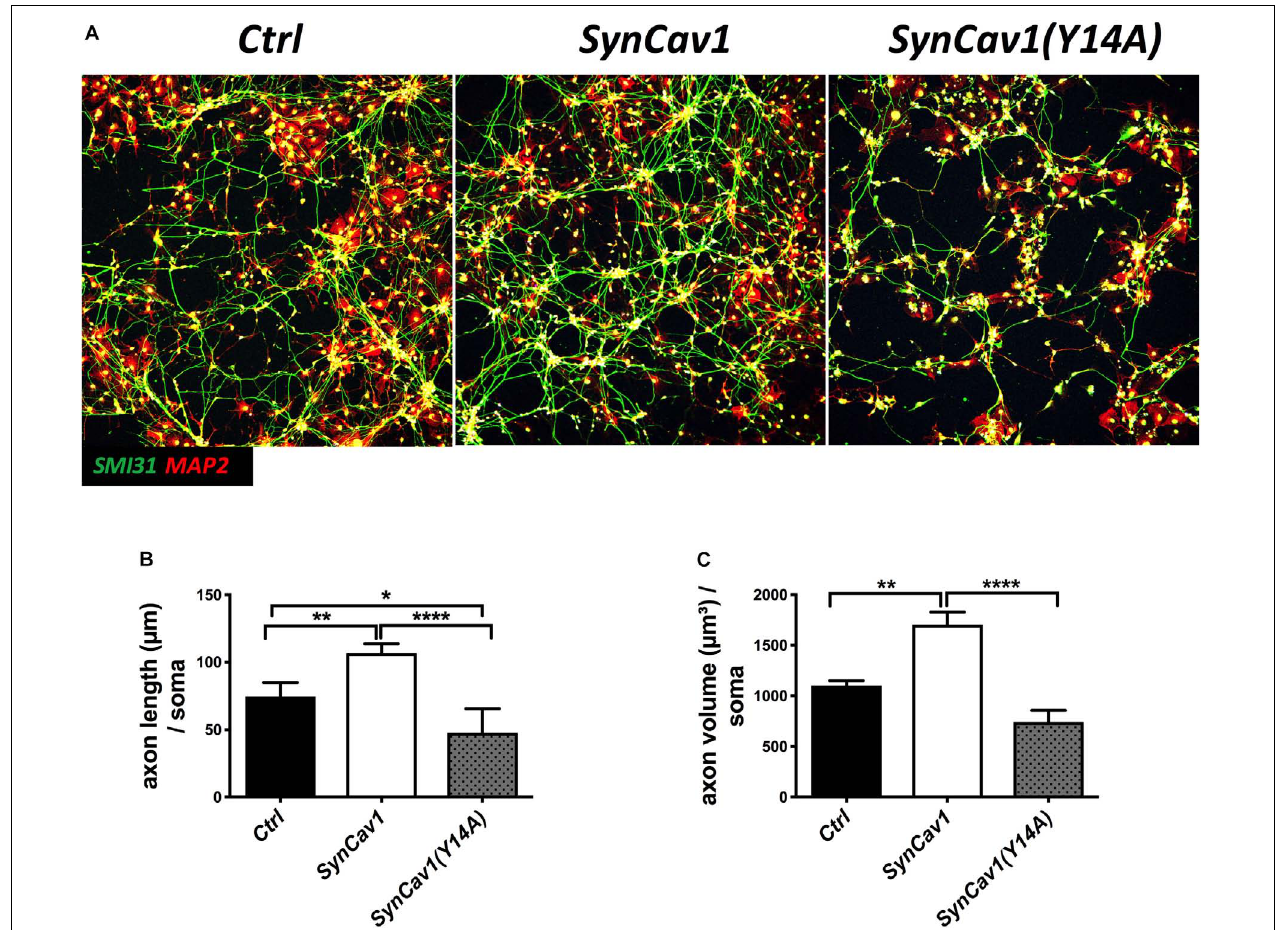
FIGURE 7 | SynCav1 (Y14A) blunts axonal growth in NPCs during differentiation. (A) NPCs were treated with Ctrl, SynCav1, or SynCav1(Y14A) (2 × 10 9 IU/ µ l) on day 3. On week 2, NPCs were stained for the dendritic marker MAP2 (red), SMI31 (green), and DAPI (blue). Quantitation of axonal length and volume are shown in (B , C) , respectively. Data are expressed as mean ± S.E ( n = 3, ∗ p < 0.05, ∗∗ p < 0.01, ∗∗∗∗ p < 0.0001, One-way